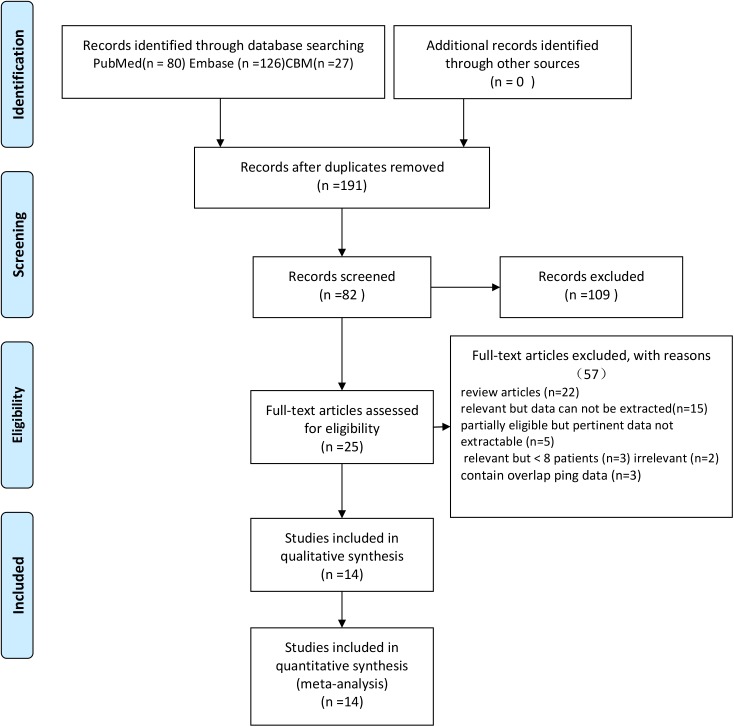
Flow diagram of the study selection process.